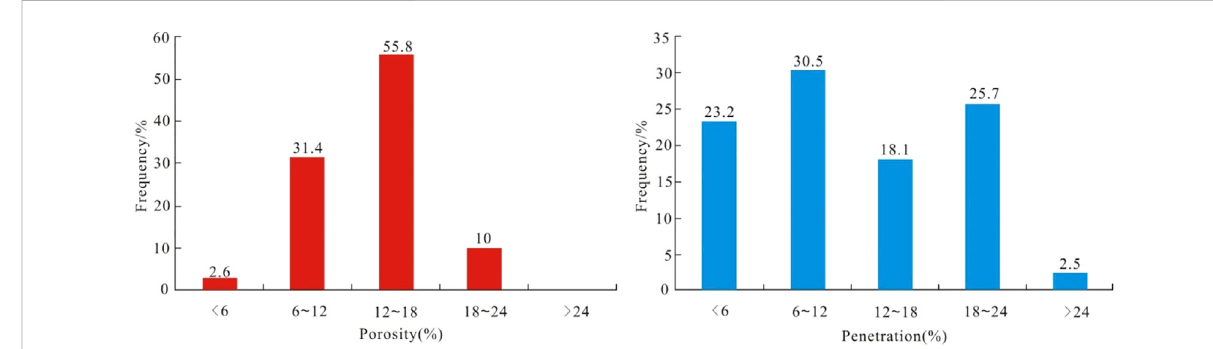
FIGURE 4 Histogram of physical property distribution of high-depth and low-permeability